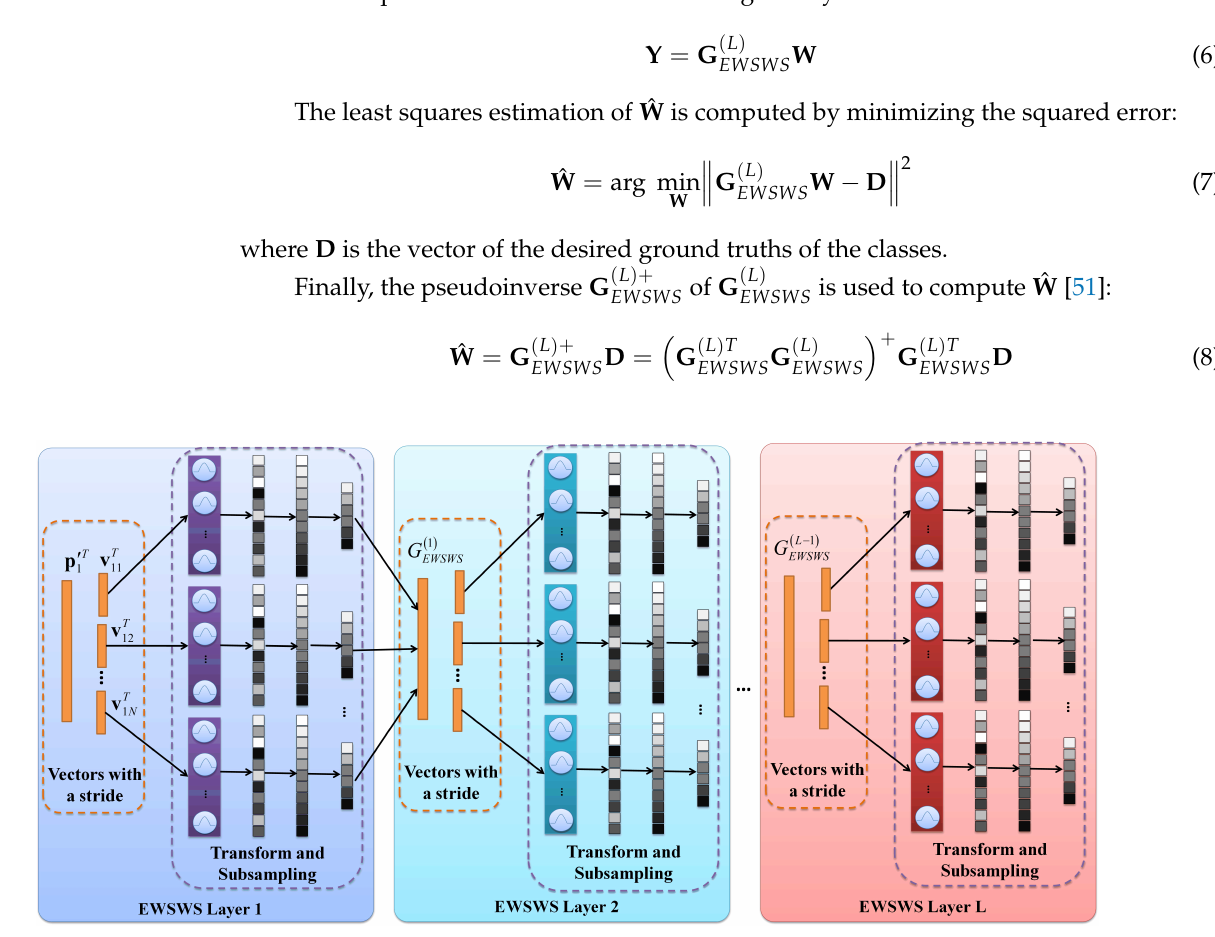
Figure 3. The architecture of the EWSWS layers. The EWSWS layers are in both the wide and deep direction. Each layer includes the transform kernels, sorting, and subsampling. The sliding window with a stride is used for each layer, and the layer is extended in the wide direction by using these sliding